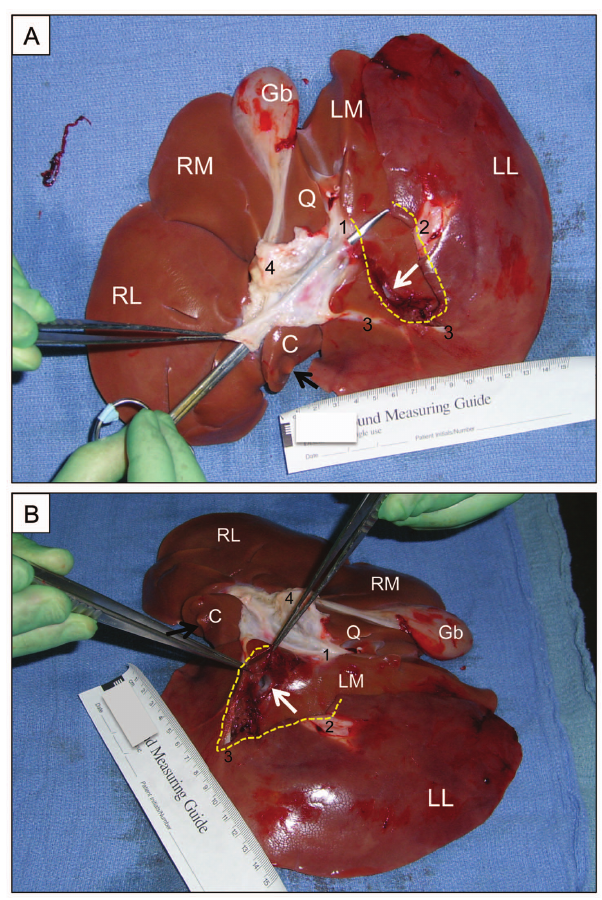
Figure 6. Postmortem liver ex vivo, demonstrating the standard injury. (A) Inferior aspect; anterior toward top of image. (B) Left inferior oblique aspect; anterior toward right of image. Scale in cm. RL=right lateral lobe; RM=right medial lobe; LM=left medial lobe; LL=left lateral lobe; Q=quadrate lobe; C=caudate lobe (black arrow indicates location of infrahepatic IVC); Gb=gallbladder. The scissors in panel A has been inserted through the cut orifice of the main portal vein, and the scissors tip are emerging through the transected 2 nd portal vein branch to the LL lobe (1); the distal end of this portal vein branch also is indicated (2). The gap in the liver parenchyma created by the injury is indicated with a dashed yellow line. The 1 st portal vein branch to the LL lobe (3), visible at the bottom of the wound, was not injured in this subject. The soft tissues (including the common bile duct and hepatic artery) overlying the portal venous system have been dissected and flipped anteriorly (4). White arrow indicates orifice of transected hepatic vein to the LL lobe; the latter has a dusky appearance relative to the other lobes.